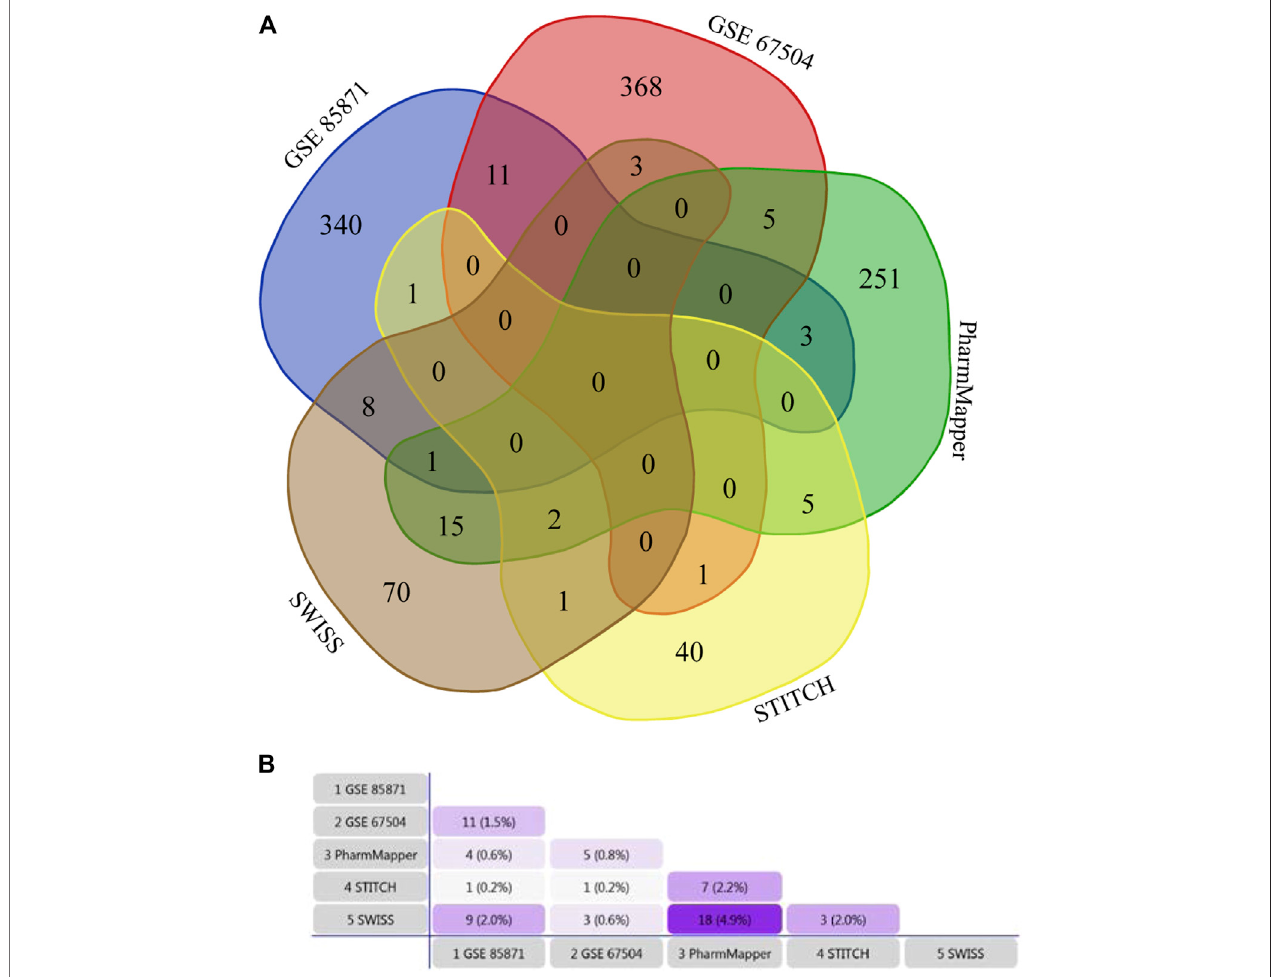
FIGURE1|(A) VenndiagrambasedonDrawVennDiagramTool,showingtheoverlappingrelationshipofGApotentialtargetsfrom fi vedatasets. (B) Venndiagram based on FunRich Tool, showing the constituent ratio of GA potential targets from fi ve datasets.